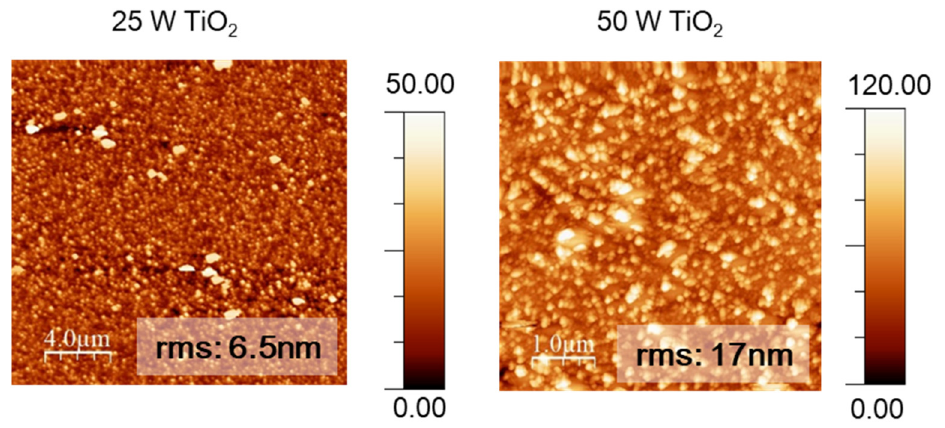
Figure 9. 2D surface topography images of the multicomponent based on Ti ‐ doped ITO matrix.